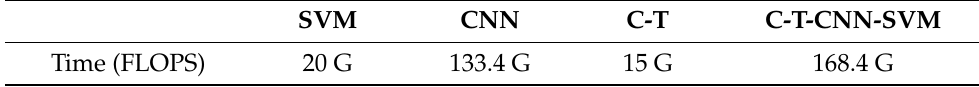
Table 2. Complexity analysis of the proposed